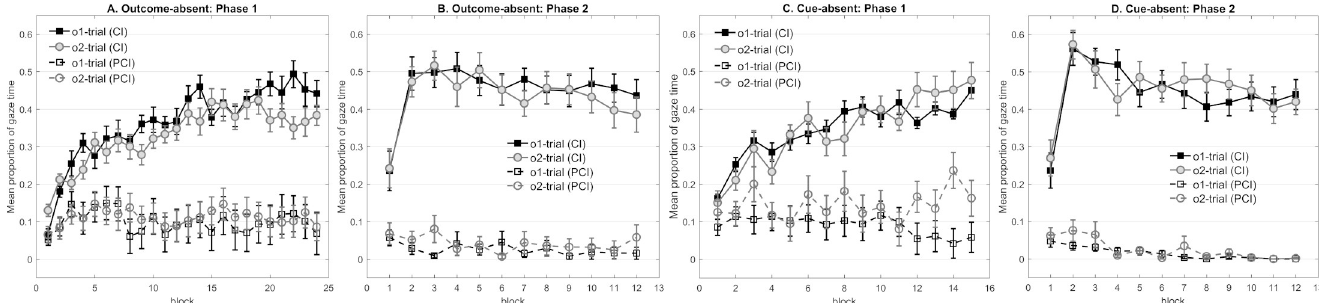
Fig 6. Panel A to D represent the mean proportion of gaze time in Experiment 4 that participants looked at the correct outcome’s cave during the cue (CI) and the pre-cue (PCI) interval respectively in each phase. (A) Mean gaze time of Group Outcome-absent across the 24 blocks in Phase 1. (B) Mean gaze time of Group Outcome-absent across the 12 blocks in Phase 2. (C) Mean gaze time of Group Cue-absent across the 15 blocks in Phase 1. (D) Mean gaze time of Group Cue-absent across the 12 blocks in Phase 2. Note that i) gaze time of Group Outcome-absent in responses to cue C in Phase 1 was averaged within each block, and ii) gaze behavior of Group Cue-outcome on the trials without signaling ( Ø ! o2) in Phase 1 was not presented in the figure.